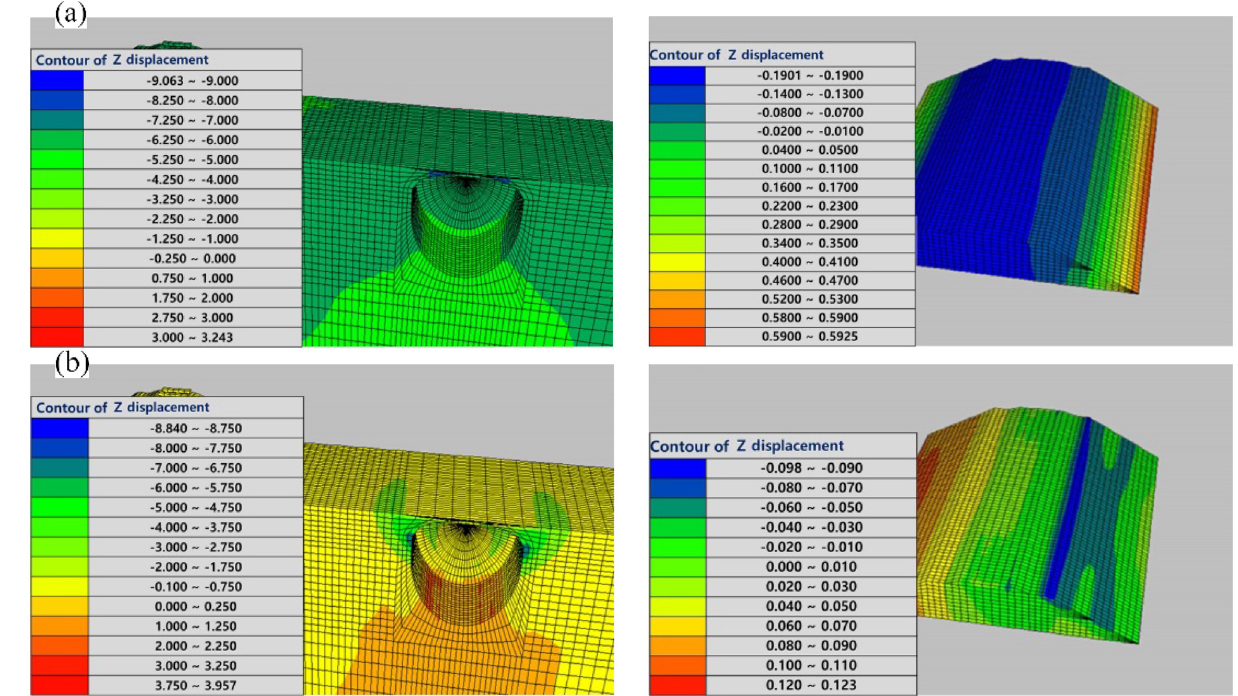
Figure 8. Vertical displacement contours of the roadbed for a cavity with a diameter of 8m, at the roadbed-to-cavity distance of 25m: (a) GWL: ground surface and (b) GWL = −